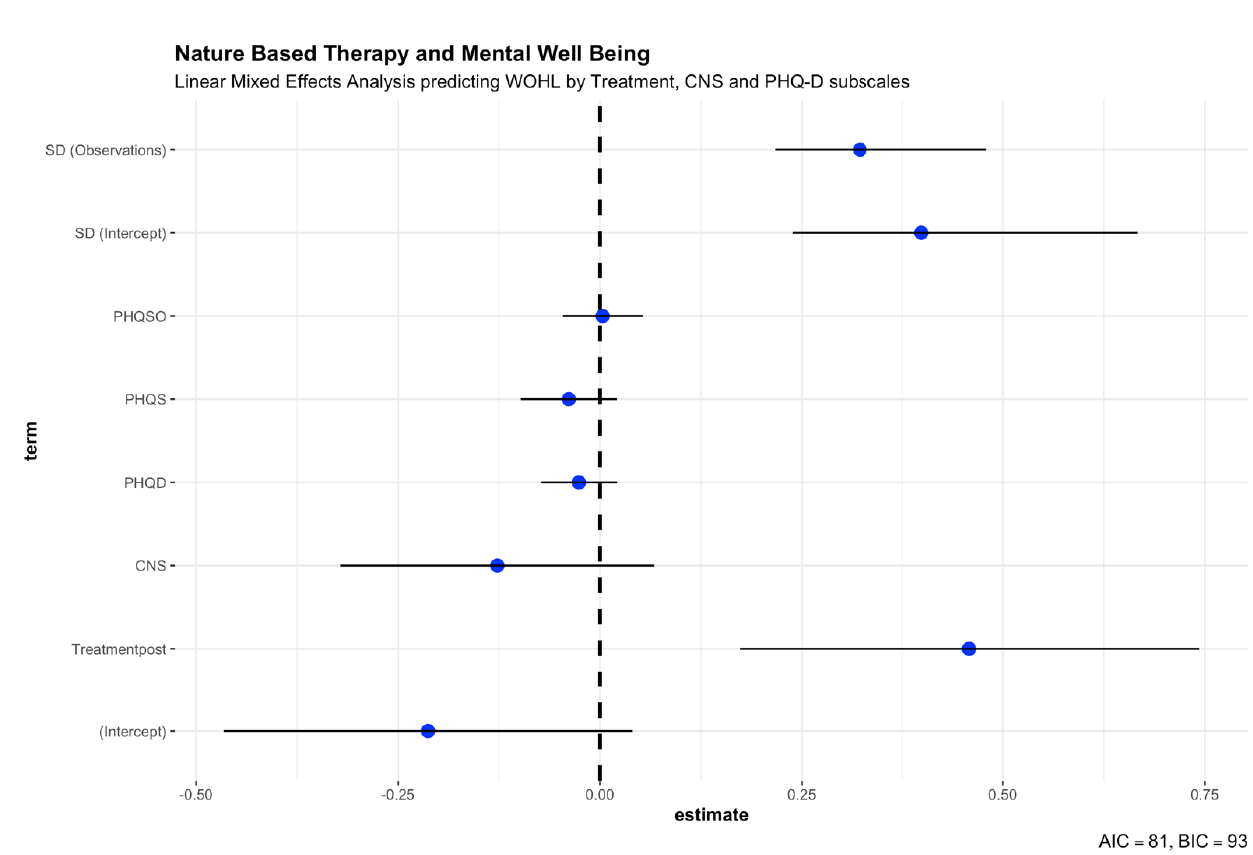
Figure 4. Linear mixed effects analysis. Model 2 predicting mental well-being (WOHL) by Treat- ment, Connectedness to Nature (CNS), and PHQ-D subscales for depression, somatoform disorders, and stress. Table 3. Linear Mixed Effects Analysis. Model 2 predicting mental well-being (WOHL) by Treat- ment, Connectedness to Nature Scale (CNS), and PHQ-D subscales (PHQ-9, PHQ-15, and stress).